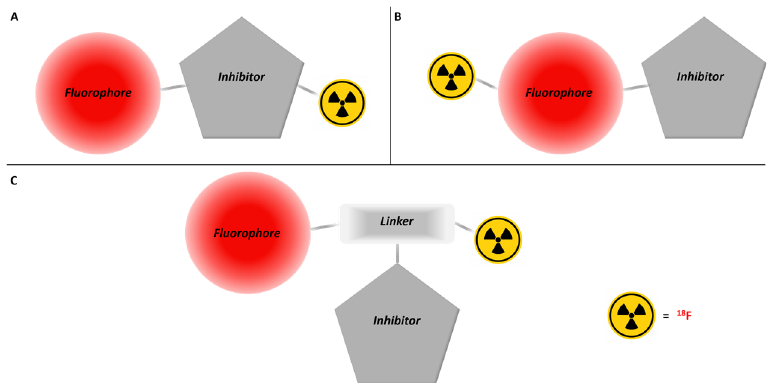
Figure 1. Schematic representations of the three main ways to link the different parts of a bimodal 18 F-labeled positron emission tomography (PET) / optical imaging (OPI) probe. ( A ) Fluorescent and radioactive tags are both attached directly on the bioactive molecule at two different locations. ( B ) The fluorescent tag is used as a radiolabeling site and is linked to the bioactive molecule. ( C ) The fluorescent tag, the radionuclide and the bioactive molecule are all linked together through a linker.